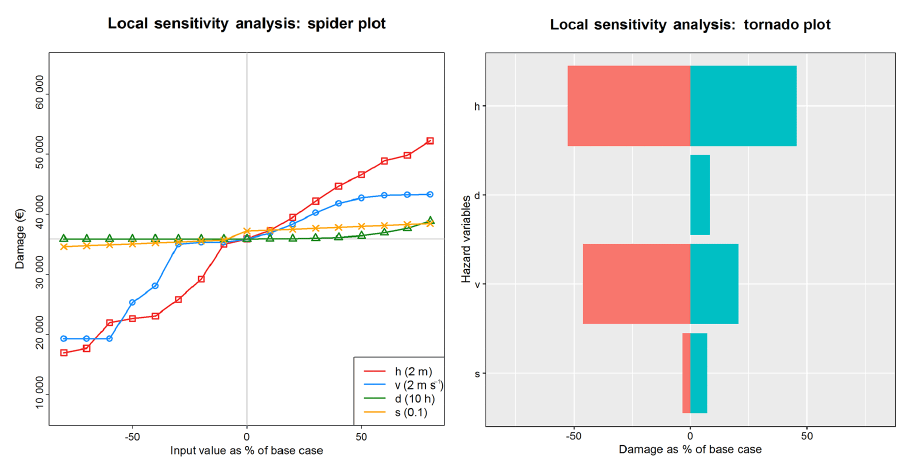
Figure 6. Results of the local sensitivity analysis in the case of high velocity, short duration